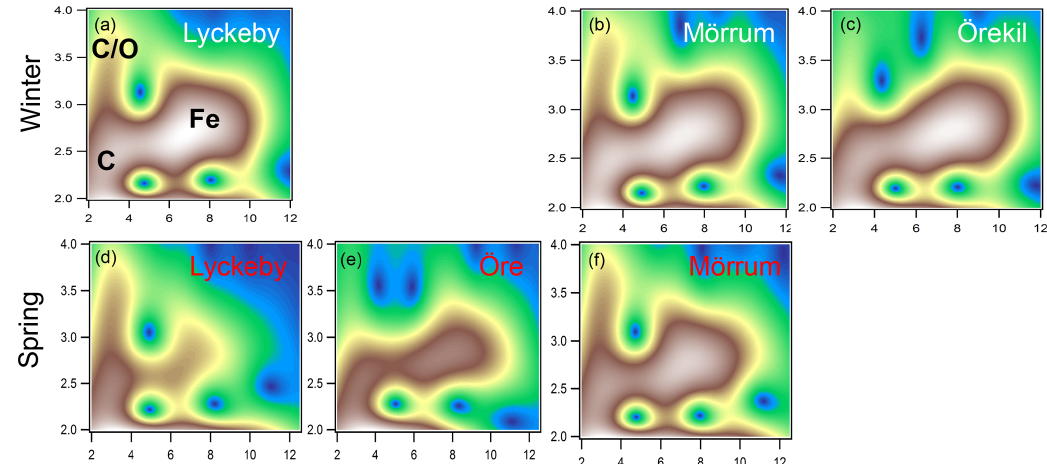
Figure 2. Morlet wavelet transforms ( η = 4, σ = 2) of EXAFS data collected on samples from the Lyckeby, Mörrum, Örekil and Öre rivers (white represents autumn and red represents spring) and are plotted as a function of k (Å − 1 ) on the x axis and R (Å) on the y axis. In panel (a) (Lyckeby) areas representing the different Fe scattering paths are indicated by C (Fe-C), C / O (Fe-C-C / O) and Fe (Fe-Fe).